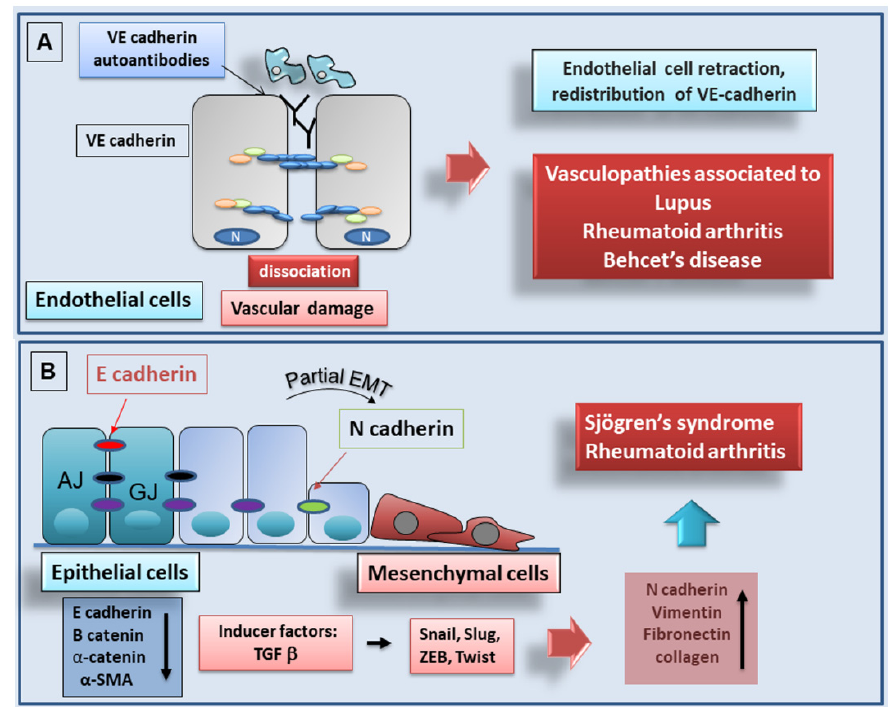
Figure 3. ( A ): potential pathogenic effect of anti-VE cadherin autoantibodies produced in the course of autoimmune diseases. Anti-VE cadherin autoantibodies, by destabilizing endothelial cell-cell interactions, induce increased vascular permeability thereby facilitating leukocyte recruitment and vascular damage. ( B ): schematic representation of the EMT process in rheumatoid arthritis and Sjögren’s syndrome. (AJ, adherens junction; GJ, gap junction).